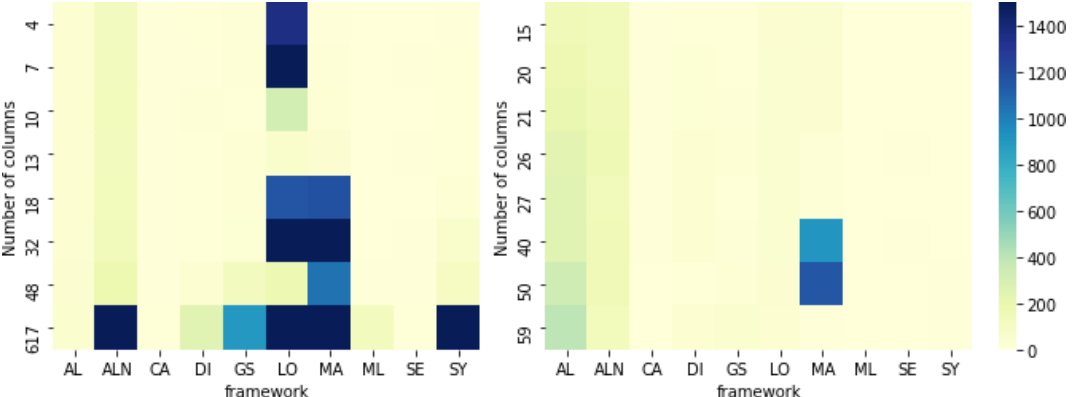
Figure 4. Heatmap with time (depending the number of columns) used by each algorithm to generate a counterfactual in datasets with only numerical features ( left ) and only categorical features ( right ). Color scale indicates the counterfactual generation time in seconds.